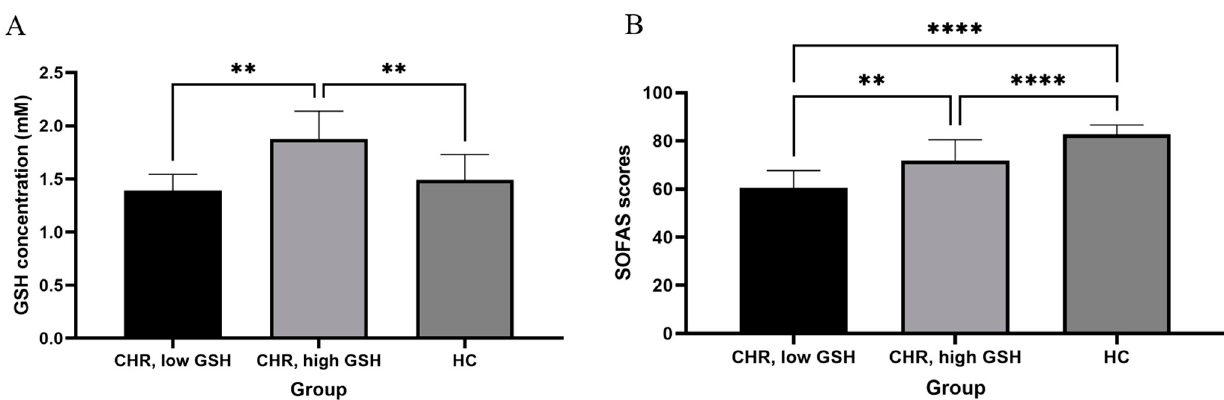
Figure 3. Median split analysis of glutathione (GSH) on the SOFAS. ( A ) Mean ( ± SD) glutathione concentrations (mM) of the low-GSH (< 1.60 mM; N = 7) and high-GSH (> 1.60 mM; N = 6) subgroups of clinical high-risk (CHR) cohorts as well as of the healthy controls (HC; N = 30). ( B ) Mean ( ± SD) SOFAS scores of the same three groups. Asterisks denote significant differences between the groups based on one-way ANOVA with the Tukey’s multiple comparison test, with ** denoting p < 0.05 and **** denoting p < 0.001.